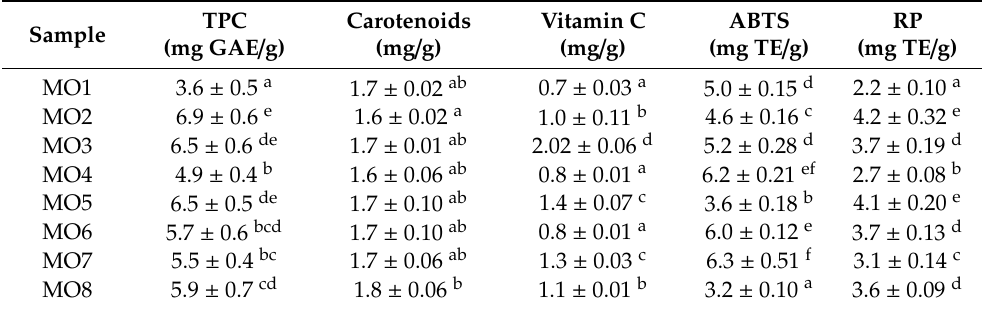
Table 1. Characteristic of powders mixtures—low-molecular-weight antioxidants and antioxidant properties.